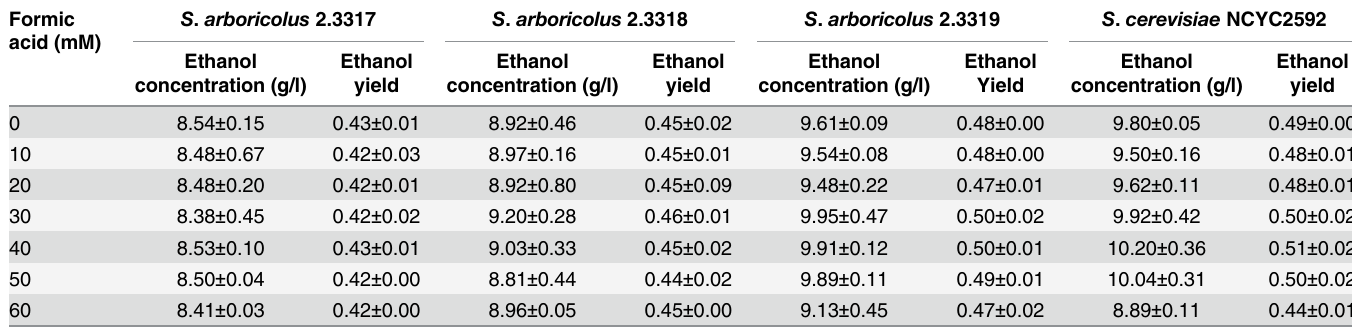
Table 3. Ethanol concentration and yield summary from Saccharomyces spp fermentation of glucose in the presence of formic acid. Data are the mean of triplicate experiments and standard deviation. Formic acid